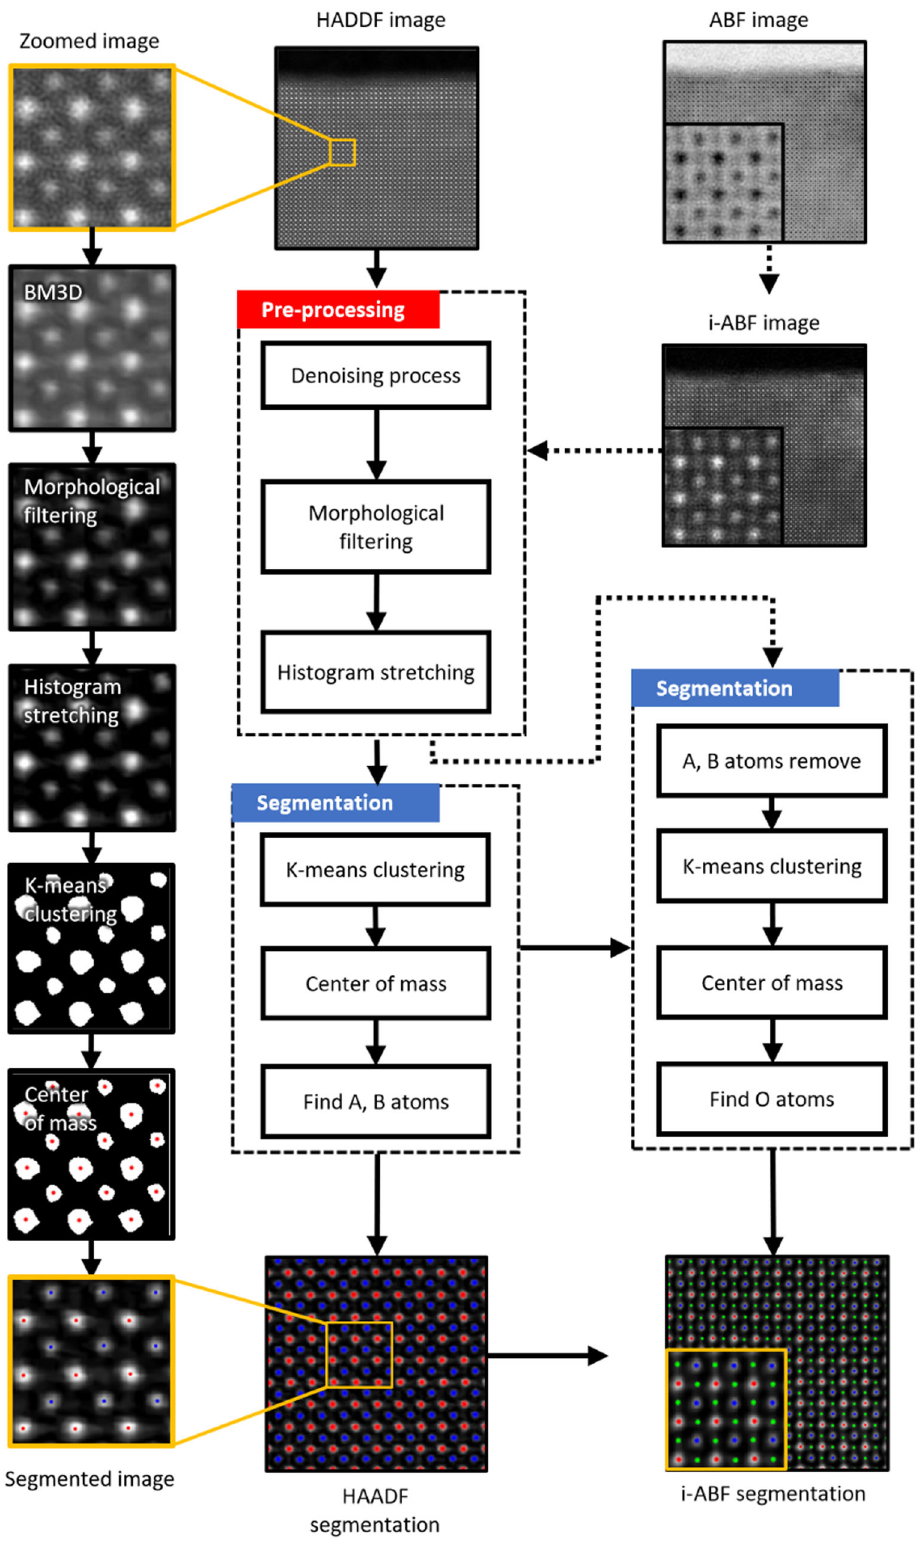
Fig. 1 Flowchart for STEM image analysis process. Entire work fl ow of precise atomic peak analysis in parallelly acquired HAADF – STEM and ABF – STEM images of SrTiO 3 along the zone axis of [100]. Preprocessing steps reduce noise and enhance the peak contrast. Segmentation steps achieve the coordinate information of atomic